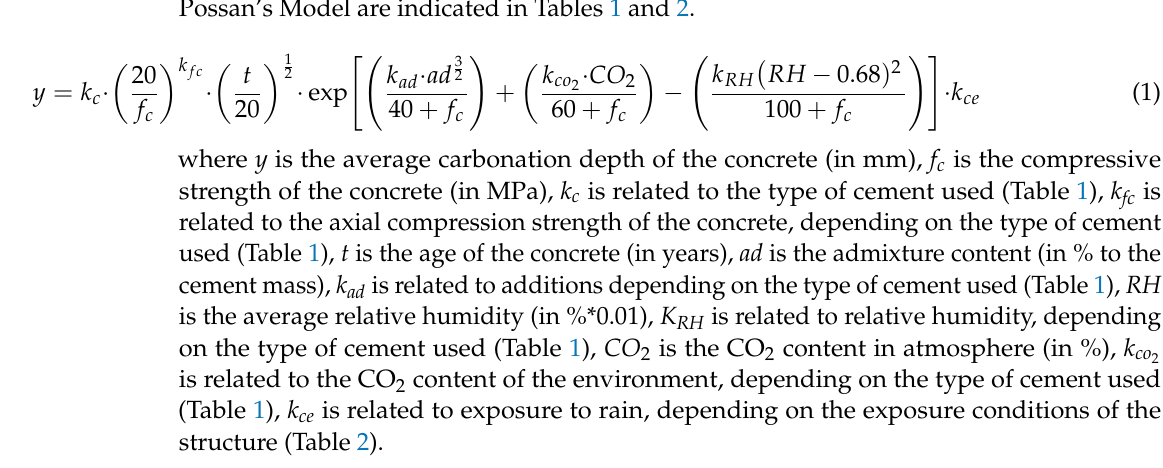
Table 1. Model coefficients as a function of concrete characteristics [20].